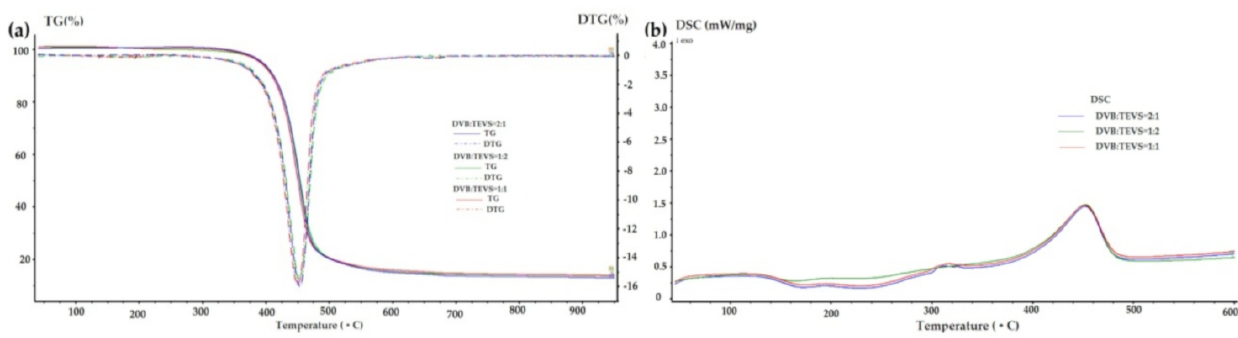
Figure 9. TG, DTG ( a ) and DSC ( b ) curves for DVB-TEVS materials measured in helium conditions. Table 5. TG, DTG and DSC data obtained in helium atmosphere for DVB-TEVS materials.